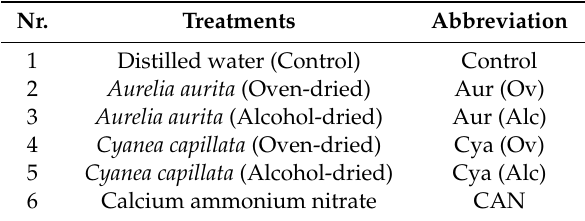
Table 4. Pot experiment treatments.